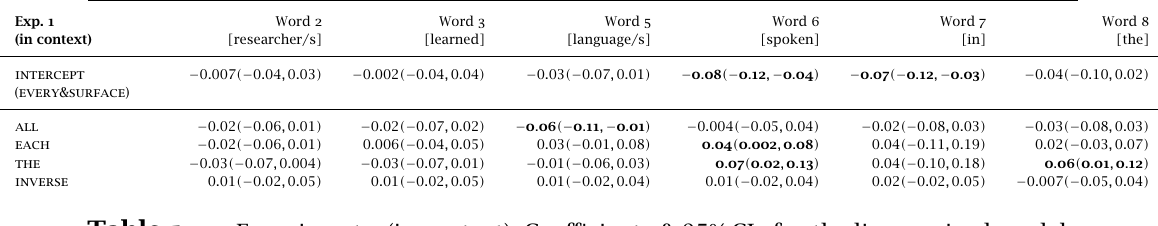
Experiment 1 (in context): Coefficients & 95 % CIs for the linear mixed models of the 6